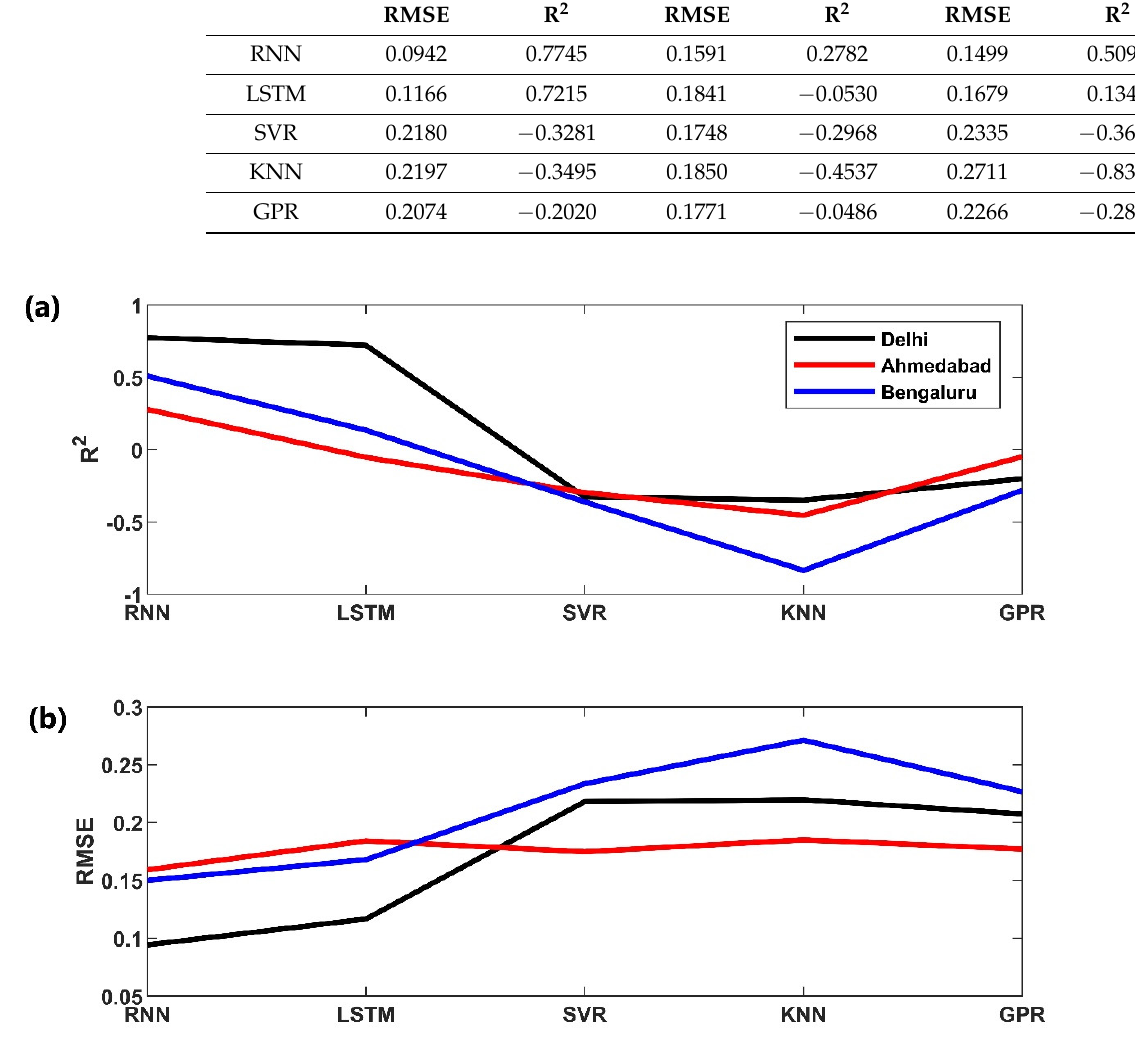
Figure 14. ( a ) R 2 and ( b ) RMSE comparison of different models for summer